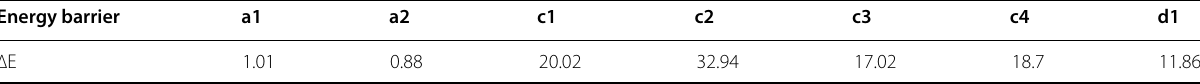
in twelve possible reaction pathways unit: Kcal/mol 2